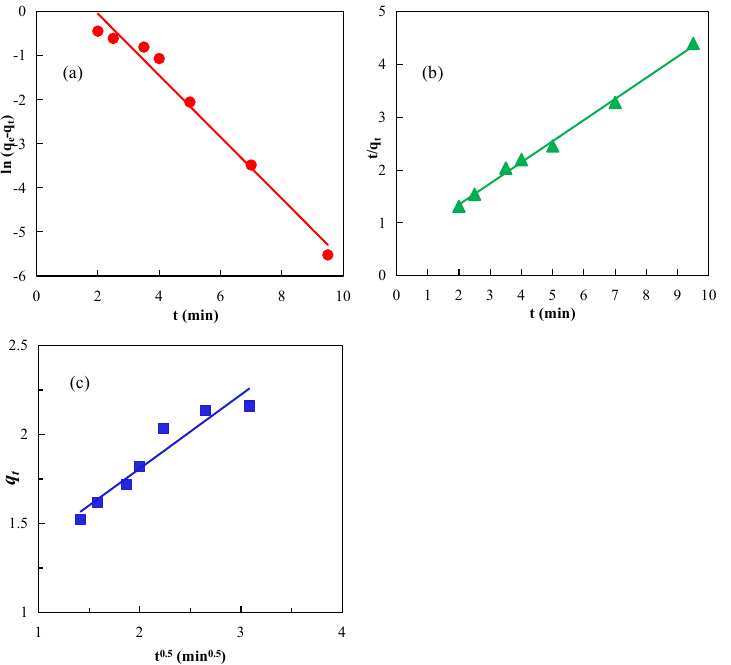
Figure 6. Kinetic adsorption data best fitting with ( a ) quasi-first-order, ( b ) quasi-second-order, and ( c ) intra-particle diffusion models.